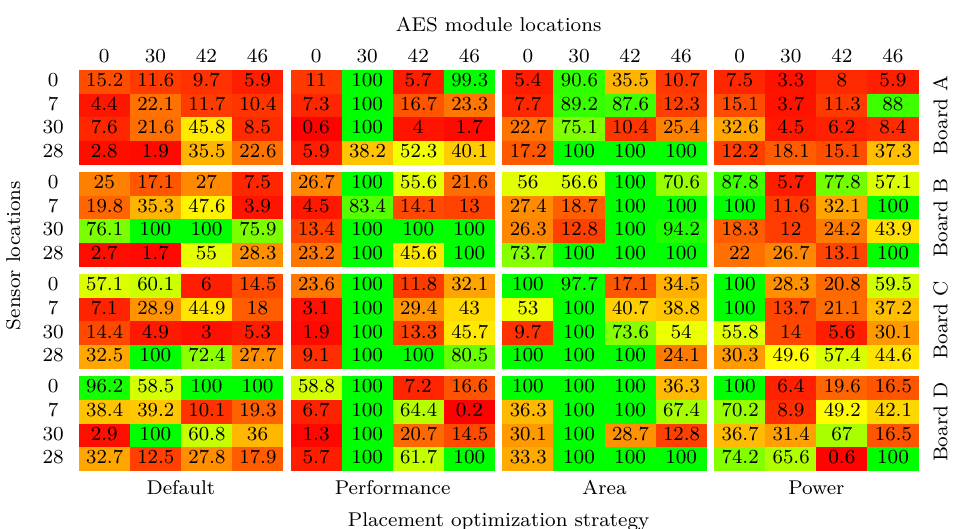
Figure 9: Minimum amount of traces ( × 1 , 000) required with different placement strategies for all possible combinations of AES and sensor location on four different Pynq-Z1 boards. Red colored cells correspond to combinations where an attack is easy, green colored to parameters resulting in a difficult attack. A value of 100 k means that we were unable to recover the key with 100 k